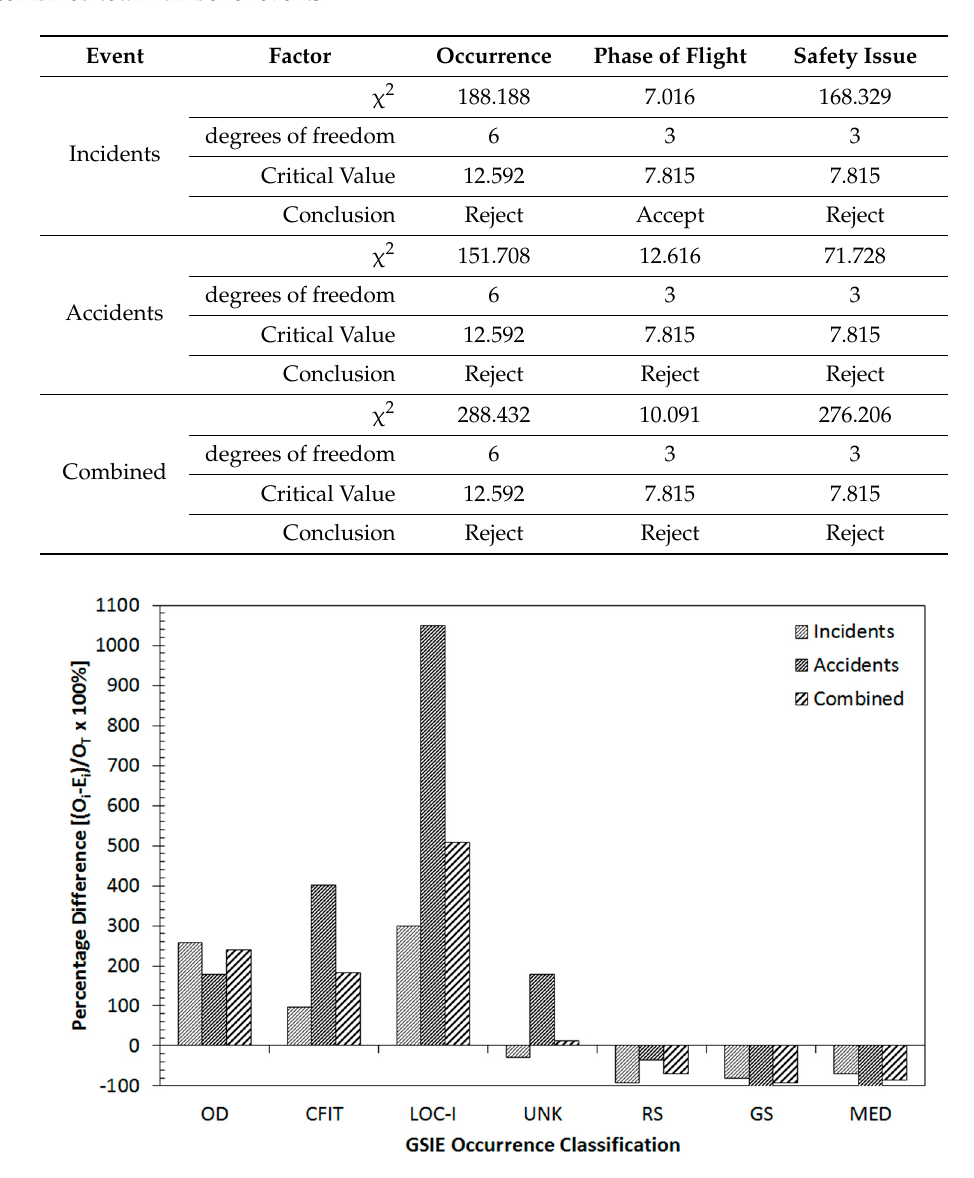
Figure 2. Relative percentage differences between observed ( O ), RPAS, and expected ( E ), CAT, showing incidents, accidents, and the combined total, for each of the Global Safety Information Exchange (GSIE) occurrence classifications.